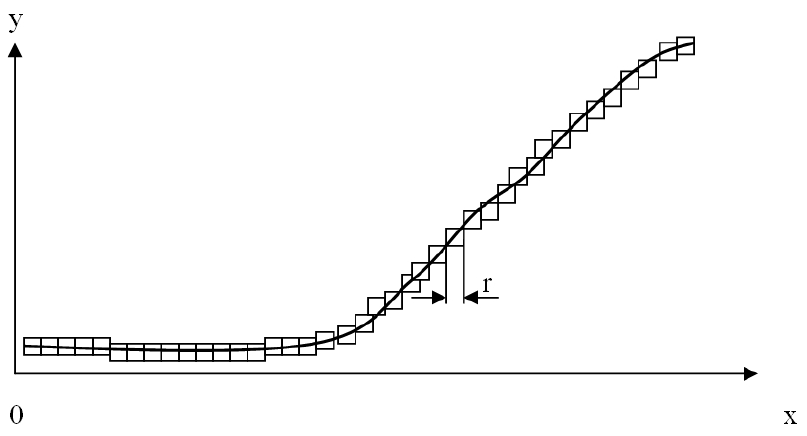
Figure 1. Illustration of the box counting algorithm for an arbitrary curve C.